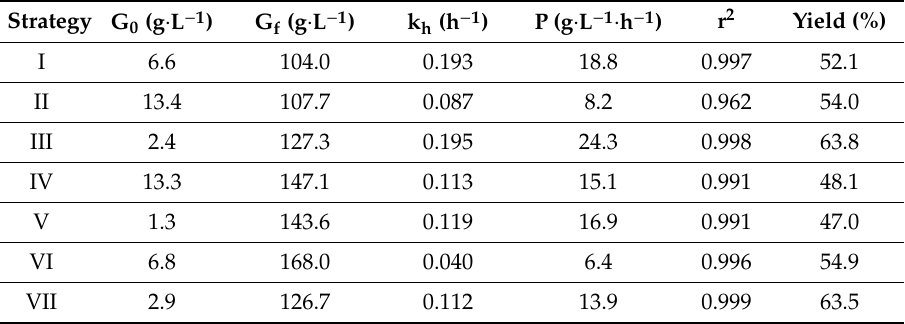
Table 5. Fed-batch enzymatic hydrolysis strategies (I, II, III, IV, V, VI, VII) at 50 ◦ C with addition of